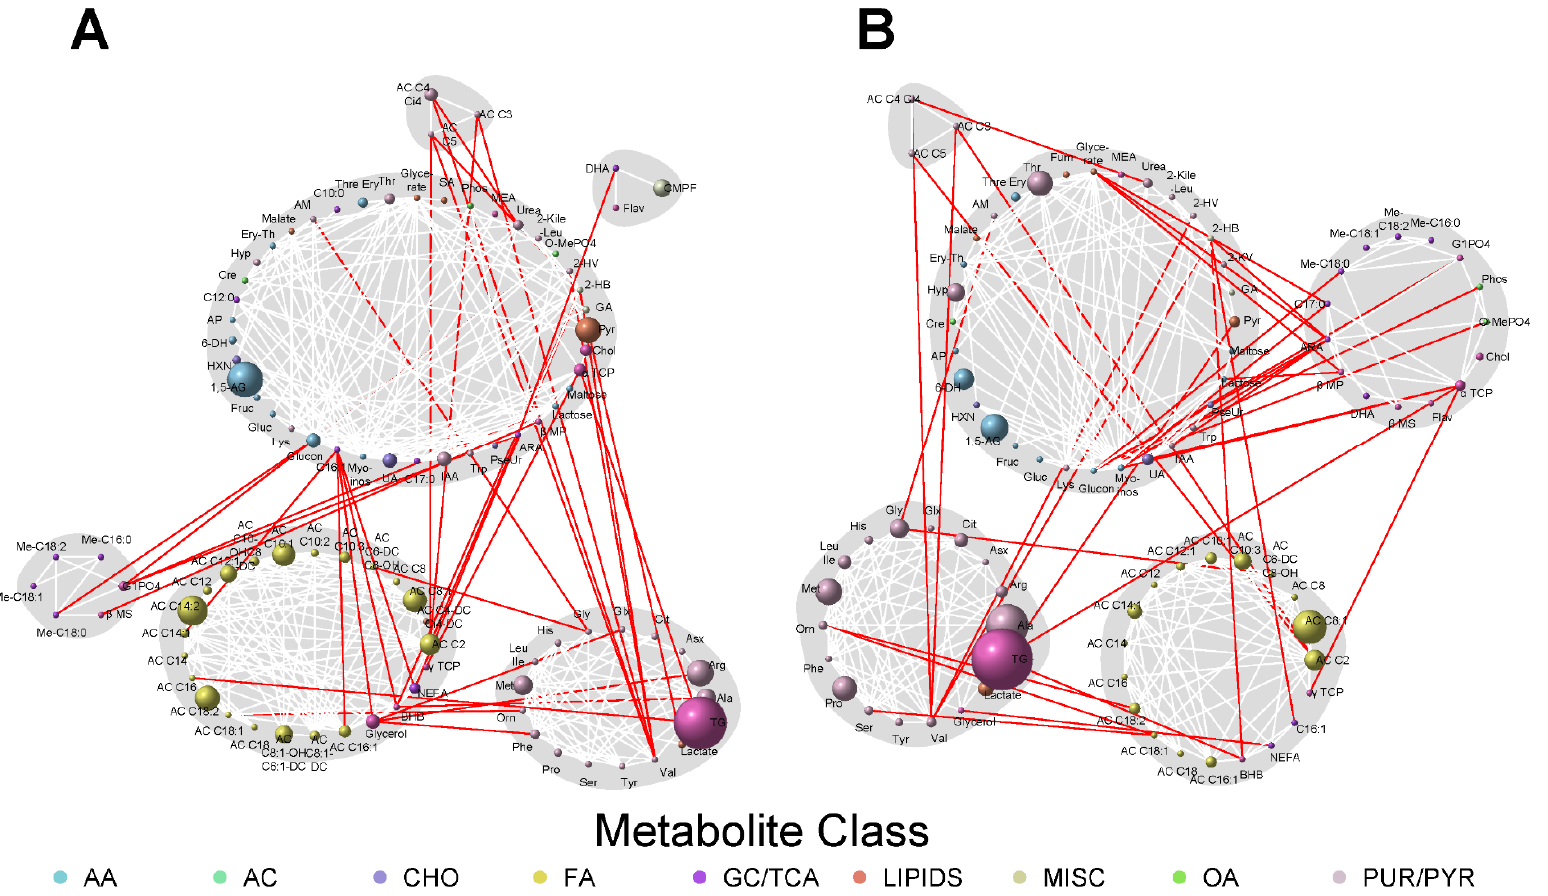
Figure 1. Maternal fasting ( A ) and 1 h ( B ) metabolite networks associated with birthweight. Grey shading represents spin-glass communities within the metabolite networks. The lines between two nodes (edges) represent dependence among metabolite pairs conditional on all other metabolites in the network according to graphical lasso. Red edges represent dependencies for metabolites in di ff erent spin-glass clusters and white edges represent dependencies for metabolites within the same spin-glass cluster. The node size of each individual metabolite re fl ects the strength of the association with each newborn outcome. A larger node size indicates a more robust association. Nodes are colored by metabolite class (AA, amino acid; AC,